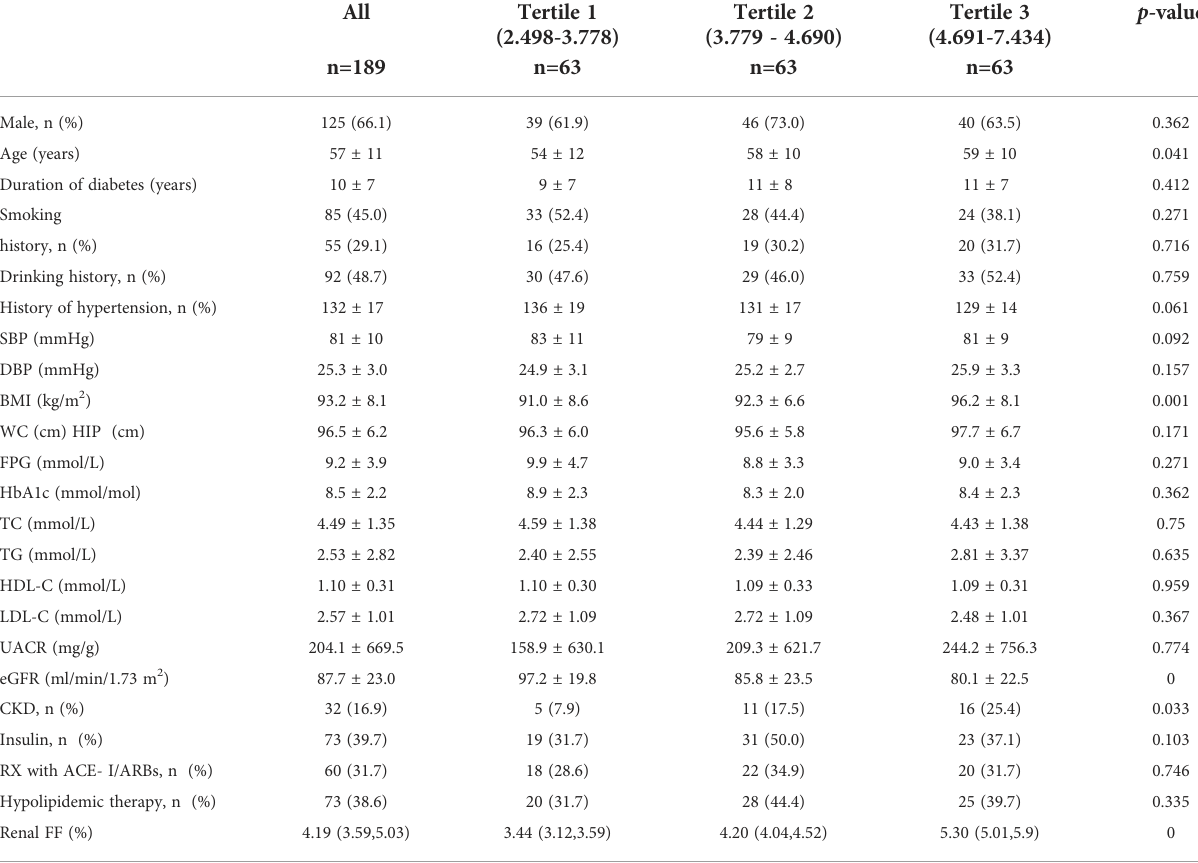
TABLE 1. Clinical features of the whole population strati fi ed across tertiles of renal FF measured by the